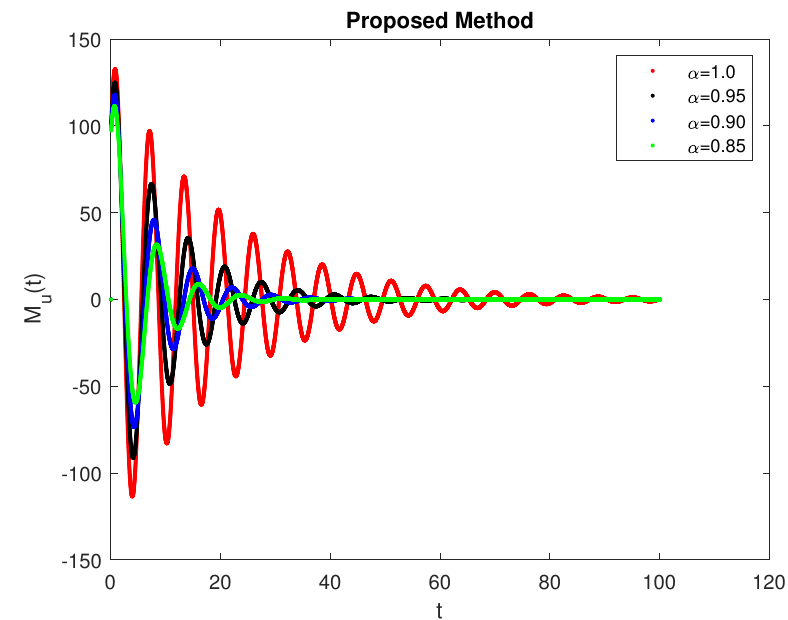
Figure 19: Numerical simulations for τ = 1 for Caputo-Fabrizio derivative.